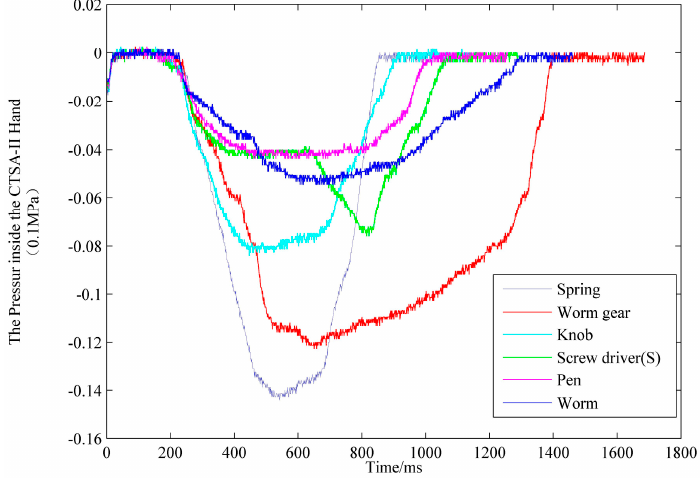
Figure 20. The change of internal pressure when the CTSA-II hand grasps objects.